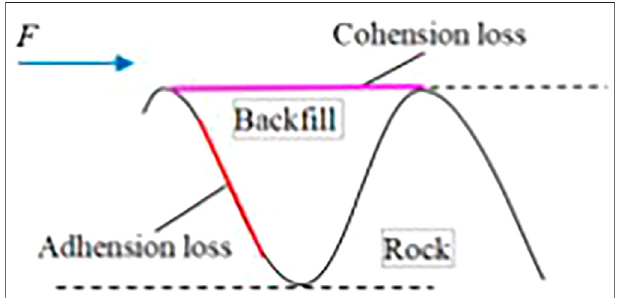
FIGURE 8 | Schematic diagram of the asperity failure